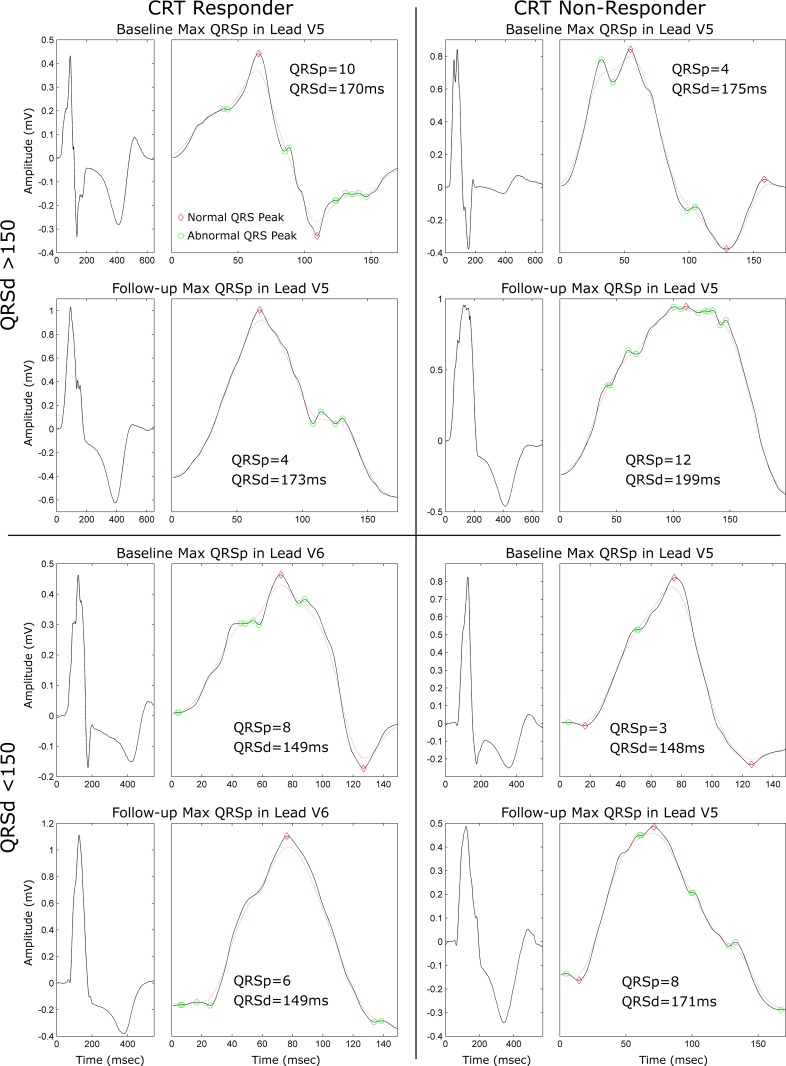
Examples of QRSp at baseline and follow-up in CRT responders and non-responders with baseline QRSd above and below 150ms.QRSp Max results at baseline and follow-up for a single 10-beat window from (top left) a CRT responder with a QRSd ≥150ms, (top right) a CRT non-responder with a QRSd ≥150ms, (bottom left) a CRT responder with a QRSd <150ms, and (bottom right) a CRT non-responder with a QRSd <150ms. Irrespective of their baseline QRSd, the CRT responders have greater baseline QRSp Max values than the non-responders. At post-CRT followup, the QRS complexes of the responders become smoother and their QRSp decreases, while the QRS complexes of non-responders become more fractionated and their QRSp increase. Solid black lines demarcate the lQRS and dashed red lines demarcate the gQRS. Normal peaks are annotated with red diamonds, and abnormal peaks are annotated with green circles.